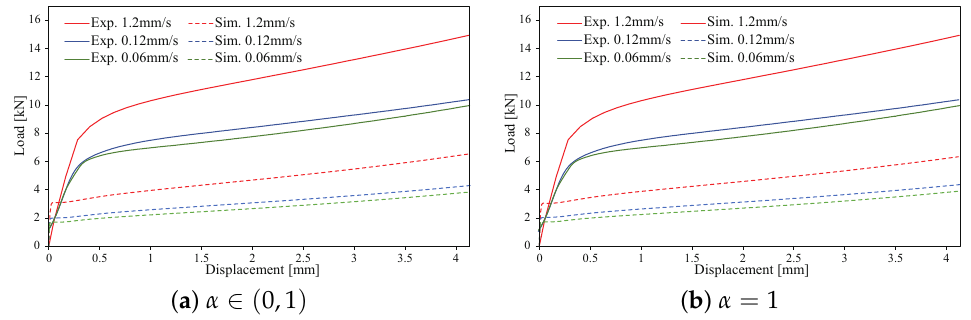
Figure 8. Load–stroke curves in the experiments and simulations using the determined material constants. The dashed lines indicate the simulation